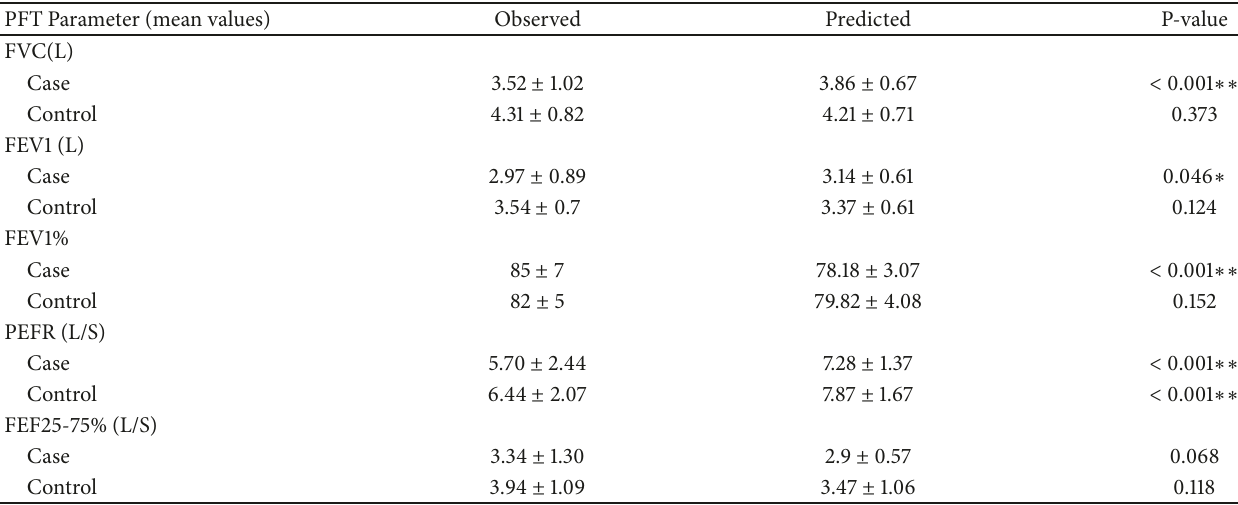
Table 4: Observed and predicted PFTs in hypertensive patients and controls at Zewditu Memorial Hospital, Addis Ababa, Ethiopia, 2017. PFT Parameter (mean values)